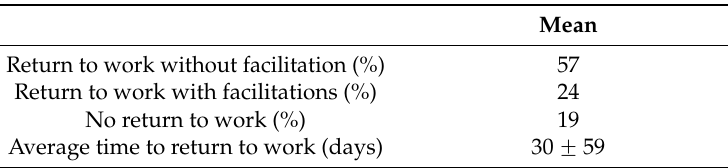
Table 4. Return to work after 5 weeks of